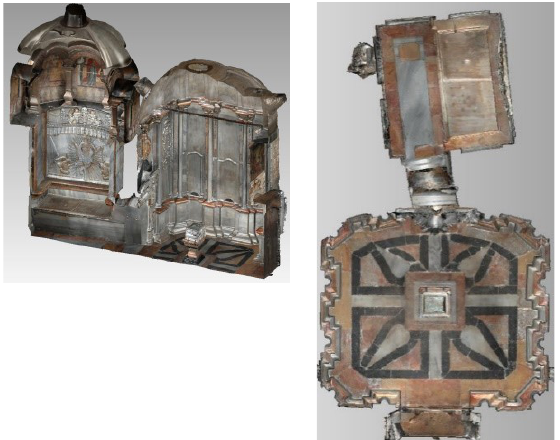
Figure 5 . Vertical and horizontal sections of the 3D model showing its interior